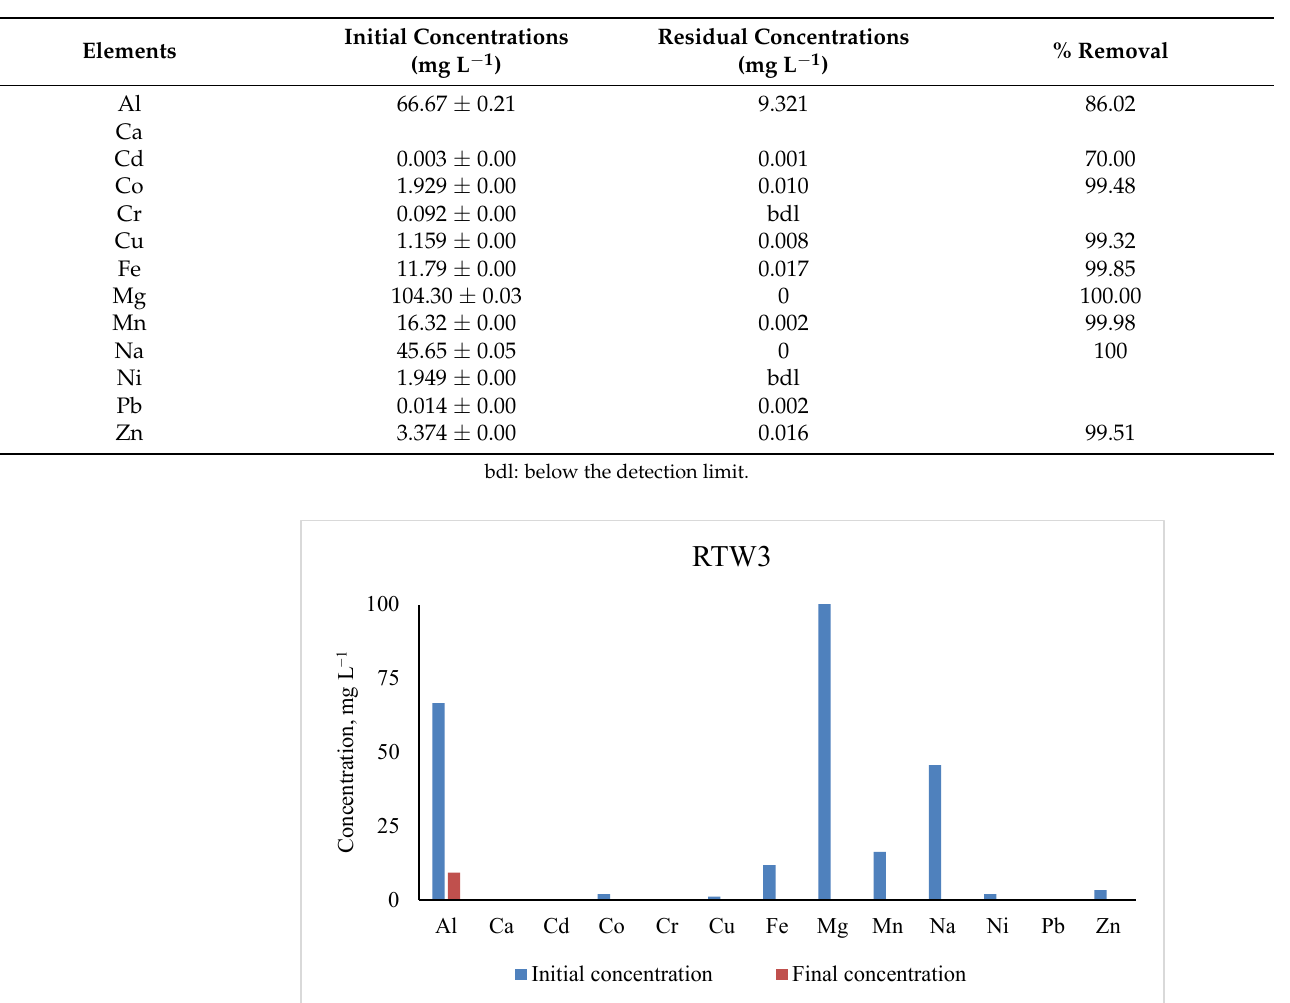
Table 6. Sampling site RTW3.